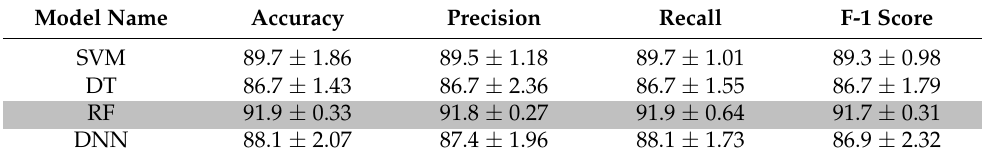
Table 10. Models’ performance for multi-class classification.